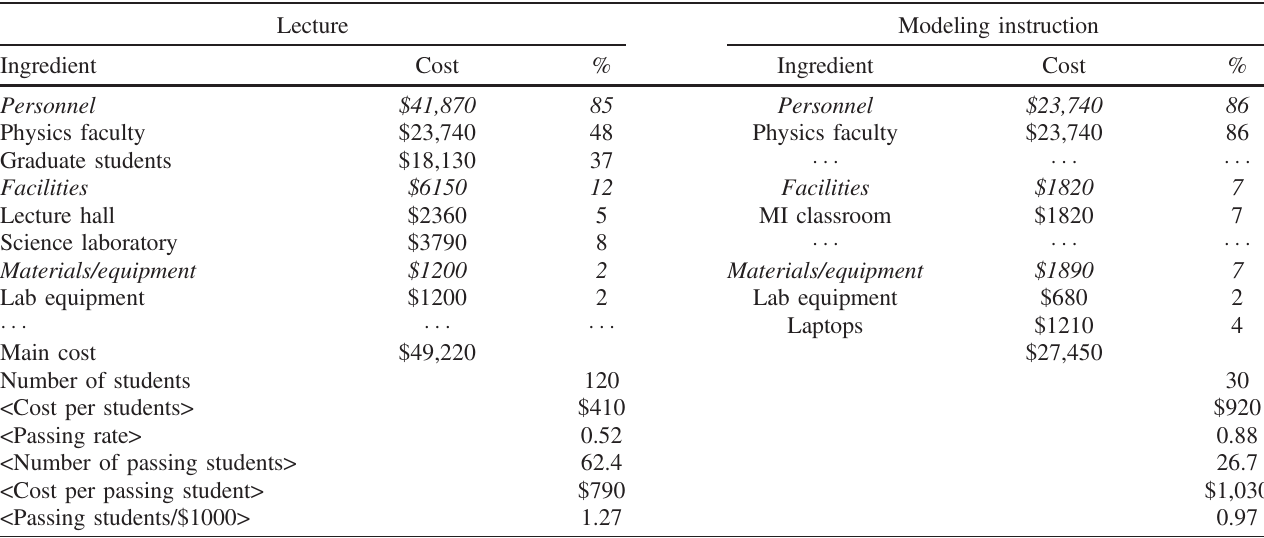
TABLE II. Costs and cost effectiveness of traditional vs Modeling Instruction physics. Note that prices are adjusted for inflation to 2013, to include fringe benefits for faculty and fringe benefits plus tuition subsidy for graduate students, and annualized at a 3.5% interest rate over 30, 10, and 5 years, respectively, for facilities, lab equipment, and computers. Passing rates are from Ref. [6]. Cost figures are rounded to the nearest $10. Categories are in